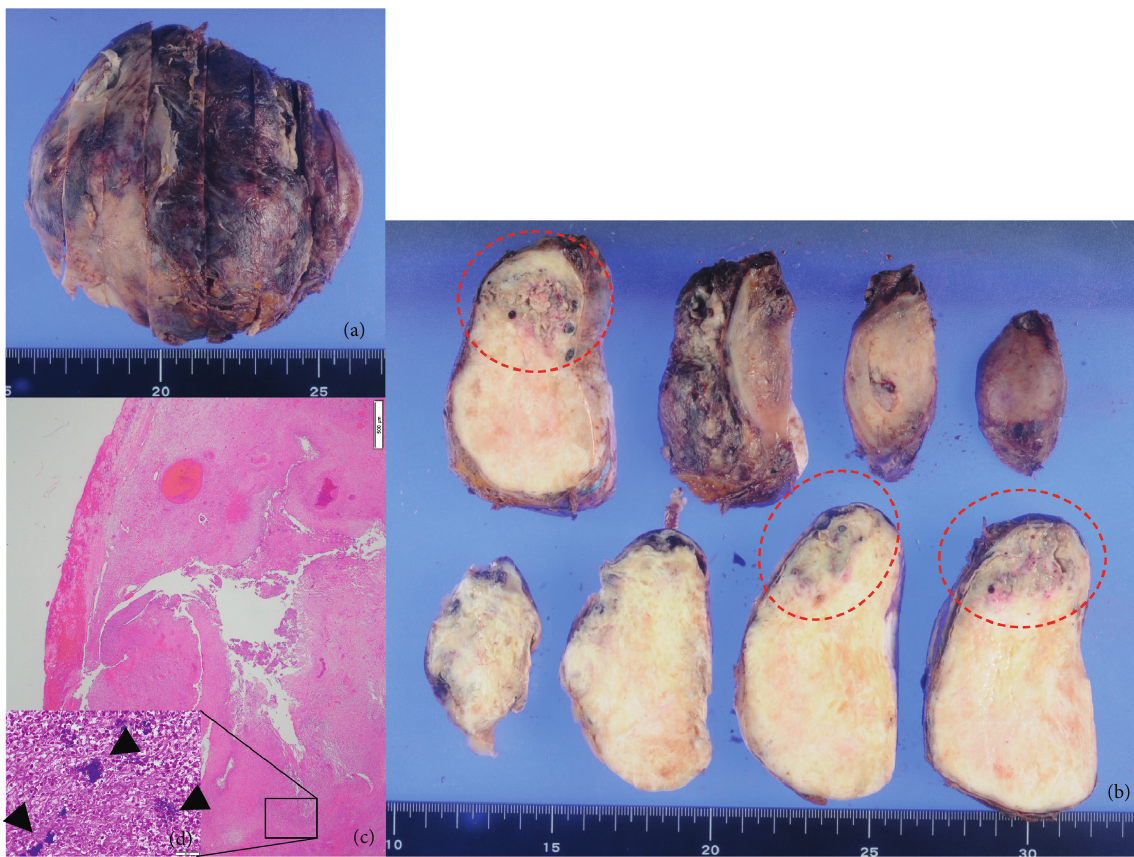
Figure 5: Pathological findings. (a) Appearance of pyometra. (b) A solid white mass of approximately 10cm in size, and yellowish fragile areas with necrosis or abscess formation in the mass (circles). (c) Histologically, there was no obvious malignancy. There were few positive findings of smooth muscle markers (SMA, Caldesmon) using immunostaining. Deposition of collagen fiber bundles was relatively prominent in the stroma, and a flower bud-like array was recognized. These findings suggested that this mass was a fibroma rather than a leiomyoma. An abscess with massive neutrophil infiltration was present in the mass, and the surrounding serosal surface showed in- flammatory cell infiltration with fibrin deposition. (d) A large mass of Gram-positive bacteria (arrowheads) was found inside the